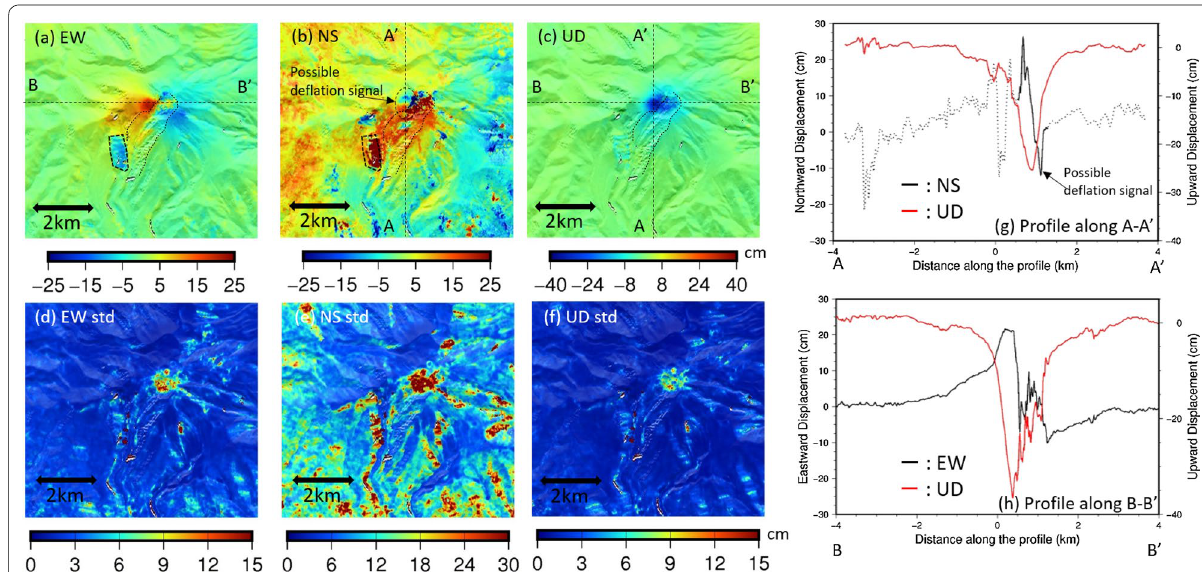
Fig. 4 Results of 3-D decomposition from October 2014 to July 2015 for the area in Fig. 1 inset. a – c Displacement distributions in the EW, NS, and UD component, respectively, d – f distributions of the standard deviation for each component. The positive values in ( a – c ) correspond to the eastward, northward, and upward displacements, respectively. Relatively large westward ( a ) and southward ( b ) motion in the area surrounded by the dashed line may be due to unwrapping error or layover. g is displacement profile of NS and UD components along A – A ′ . h Displacement profile of EW and UD components along B – B